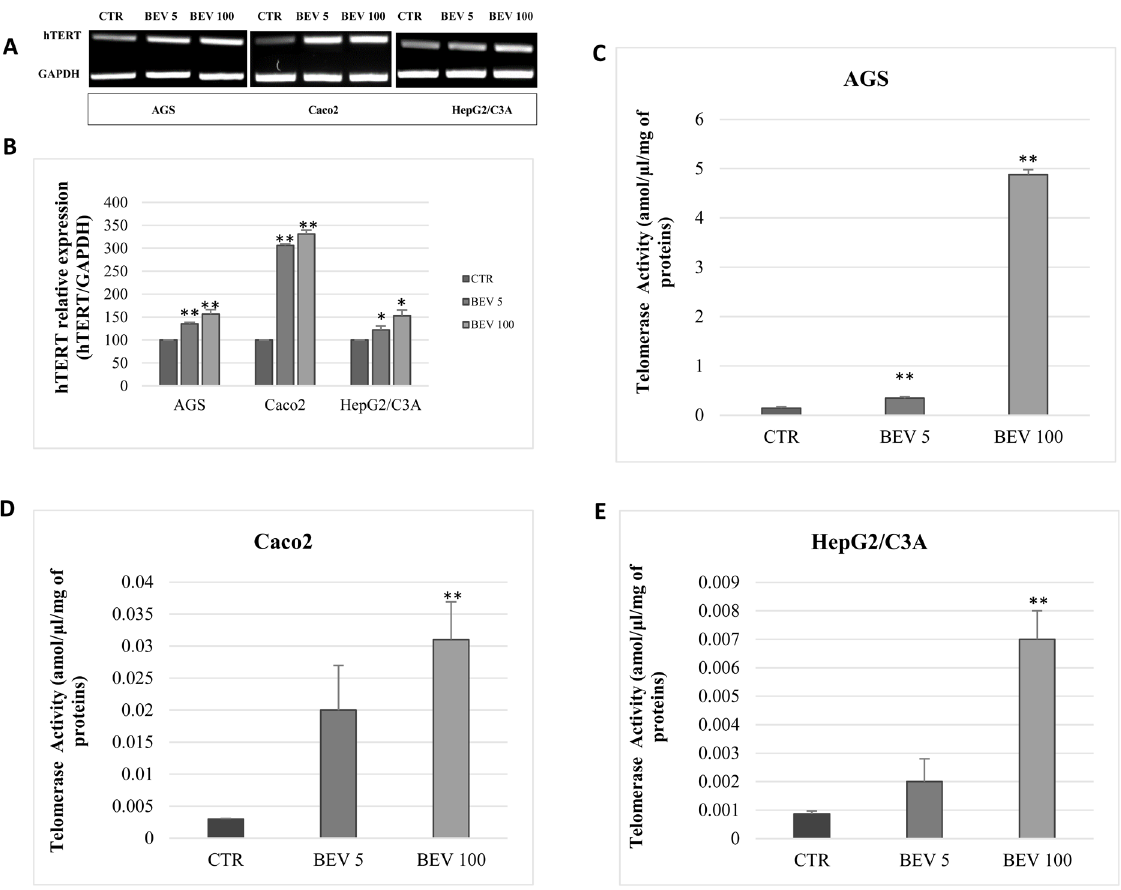
Fig 2. VEGF inhibition with bevacizumab increases hTERT expression and telomerase activity. (A) Semi-quantitative RT-PCR analysisof hTERT expressionfrom AGS, Caco2, and HepG2/C3Acells treated for 48 h with bevacizumab at 5 ng/ml and 100 μ g/ml. GAPDH was used as a loadingcontrol. (B) The amount of transcripts referred to in (A) were quantifiedby real-time PCR with GAPDH as an internalcontrol. (C, D, E) Telomerase activity was detected in AGS (C), Caco2 (D), and HepG2/C3A (E). Results were expressedas the mean ± SD from three